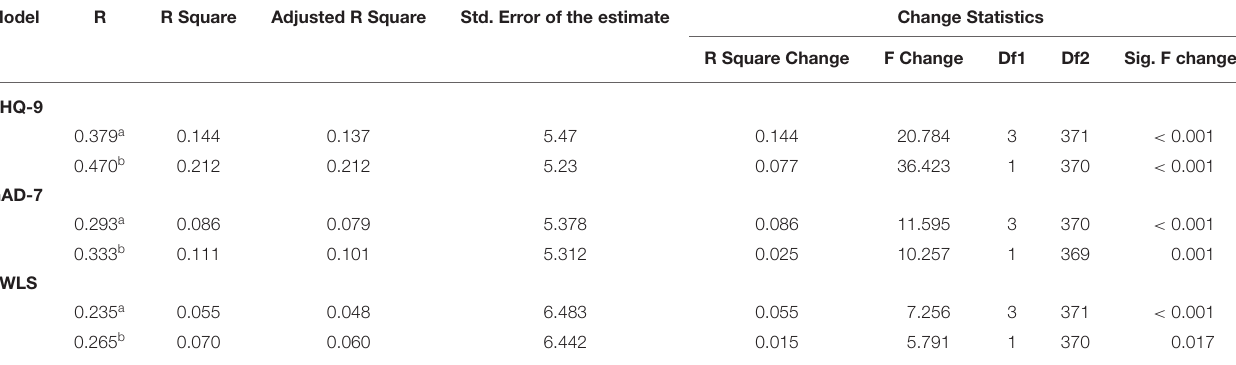
TABLE 3 | Results of hierarchical regression analyses, examining associations between change in MVPA and mental health outcomes.